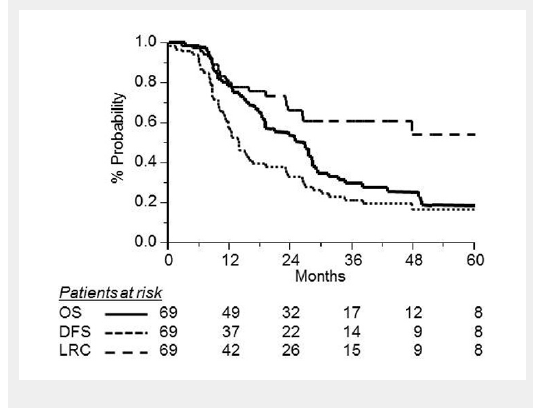
Kaplan-Meier curves for overall survival (OS, solid line; DFS, dotted line; and LRC, dashed line) in 69 patients with limited stage small- cell lung cancer.